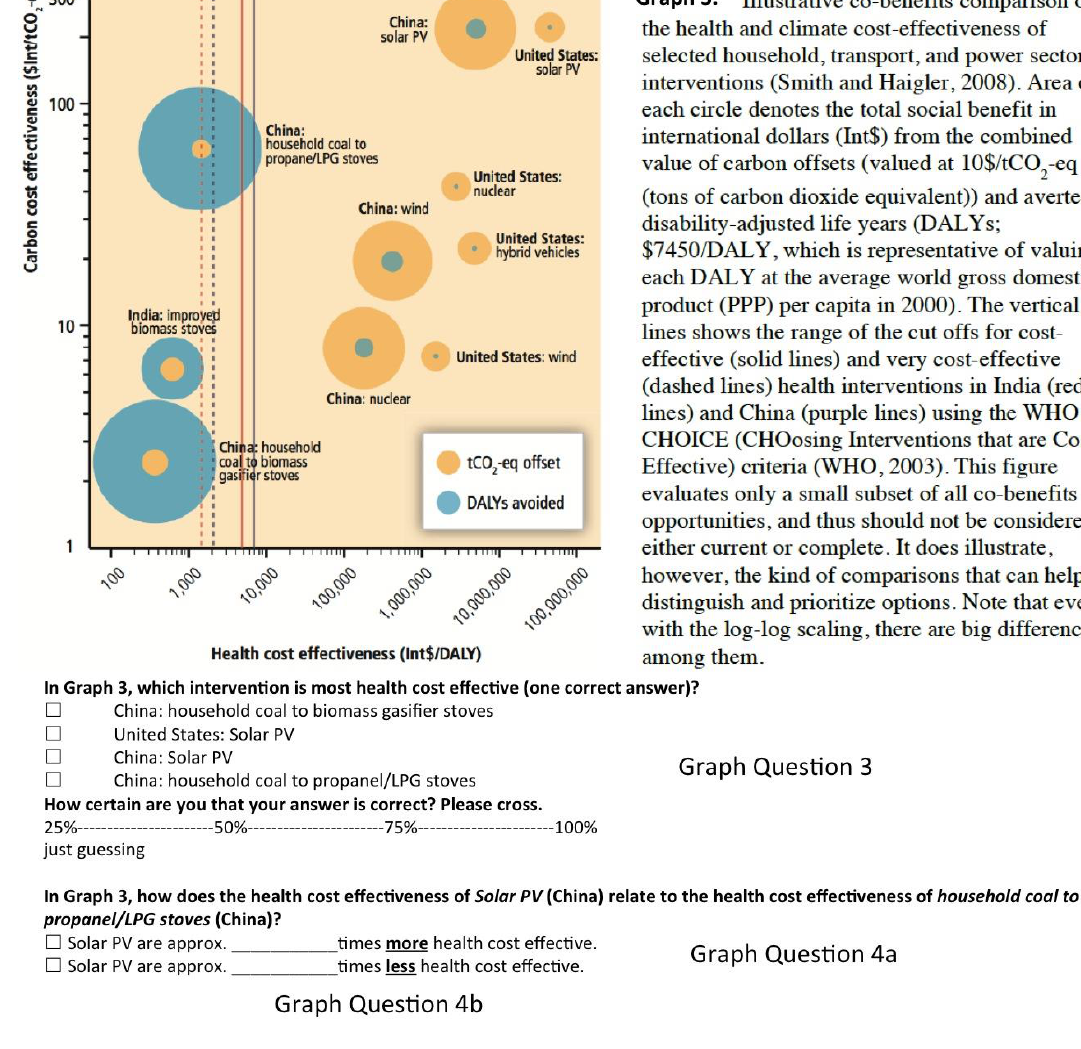
Figure 1 . Sample graph taken from the International Panel on Climate Change (IPCC)’s chapter on human health, together with objective and subjective understanding questions. Here: Graph 3, together with Graph questions 3, 4a and 4b.